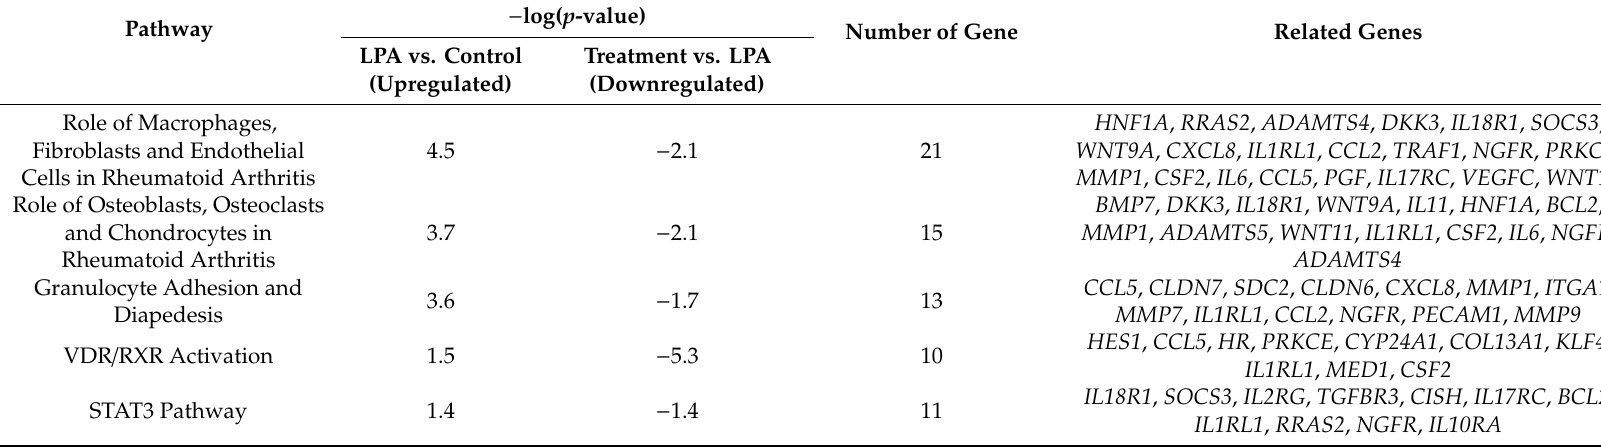
Table 3. Di ff erential biological pathways between LPA treated vs. control and LPA plus KA-1002 treated vs. LPA treated swine macrophage. − log( p -value) Pathway Number of Gene Related Genes LPA vs.